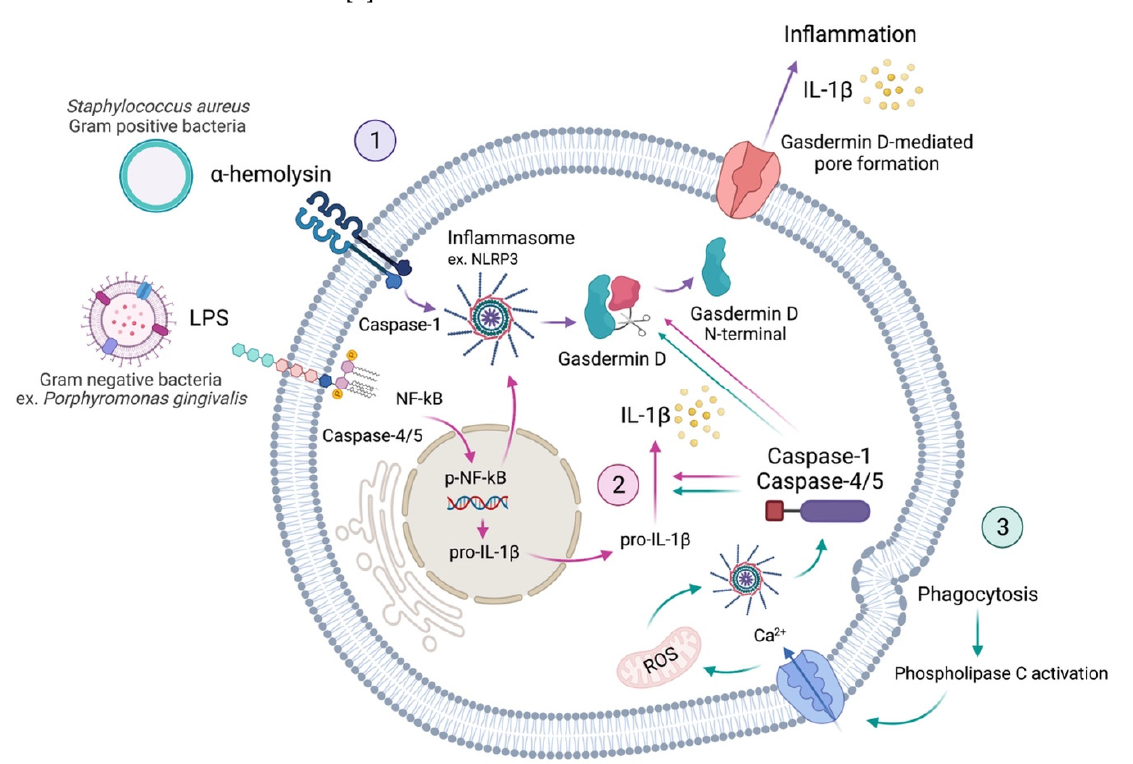
Figure 1. Schematic representation of the pyroptosis activation in a cell. Virulence factors, such as α -hemolysin and LPS, activate inflammasome immune responses by activating caspases. Activated caspase-1 (canonical) and caspases-4/5 (non-canonical) recognise and cleave gasdermin D. The N-terminal fragment, resulting from Gasdermin D cleavage, is responsible for pore formation on the cell membrane. These pores allow the release of interleukins and thus induce the inflammation process called pyroptosis (1, purple arrows). Additionally, activated inflammasomes are responsible for cleaving caspases into subunits, which induce the maturation of pro-inflammatory cytokines, such as pro-interleukin-1 β (pro-IL-1 β ). Activated IL-1 β can induce the expression of various genes, including RANKL (receptor activator of p-NF- κ B ligand) and activate pyroptosis (2, pink arrows). Furthermore, phagocytosis can lead to pyroptosis through the activation of phospholipase C, which allows the intake of calcium (Ca 2+ ), provoking the production of mitochondrial reactive oxygen species (ROS), which can also activate the inflammasome route (3, green arrows) [5,11]. With the discovery of NLRP3, GSDMD, and caspase-1 as significant drivers of py-